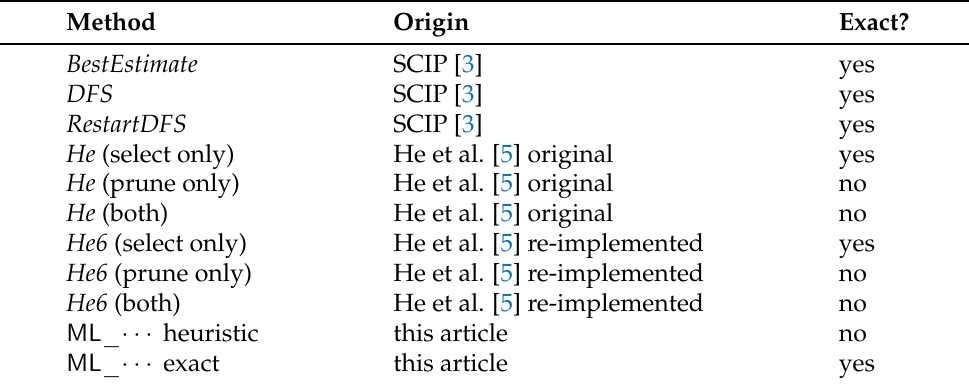
Table 3. Summary of methods compared in the